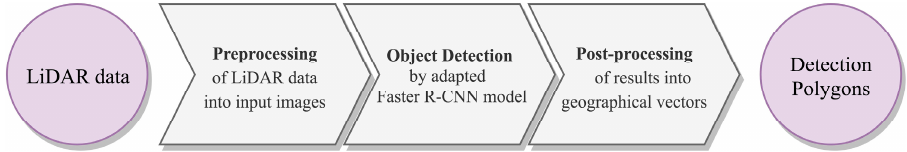
Figure 5. Simplified representation of WODAN (Workflow for Object Detection of Archaeology in The Netherlands; for a comprehensive overview see Reference [50]).